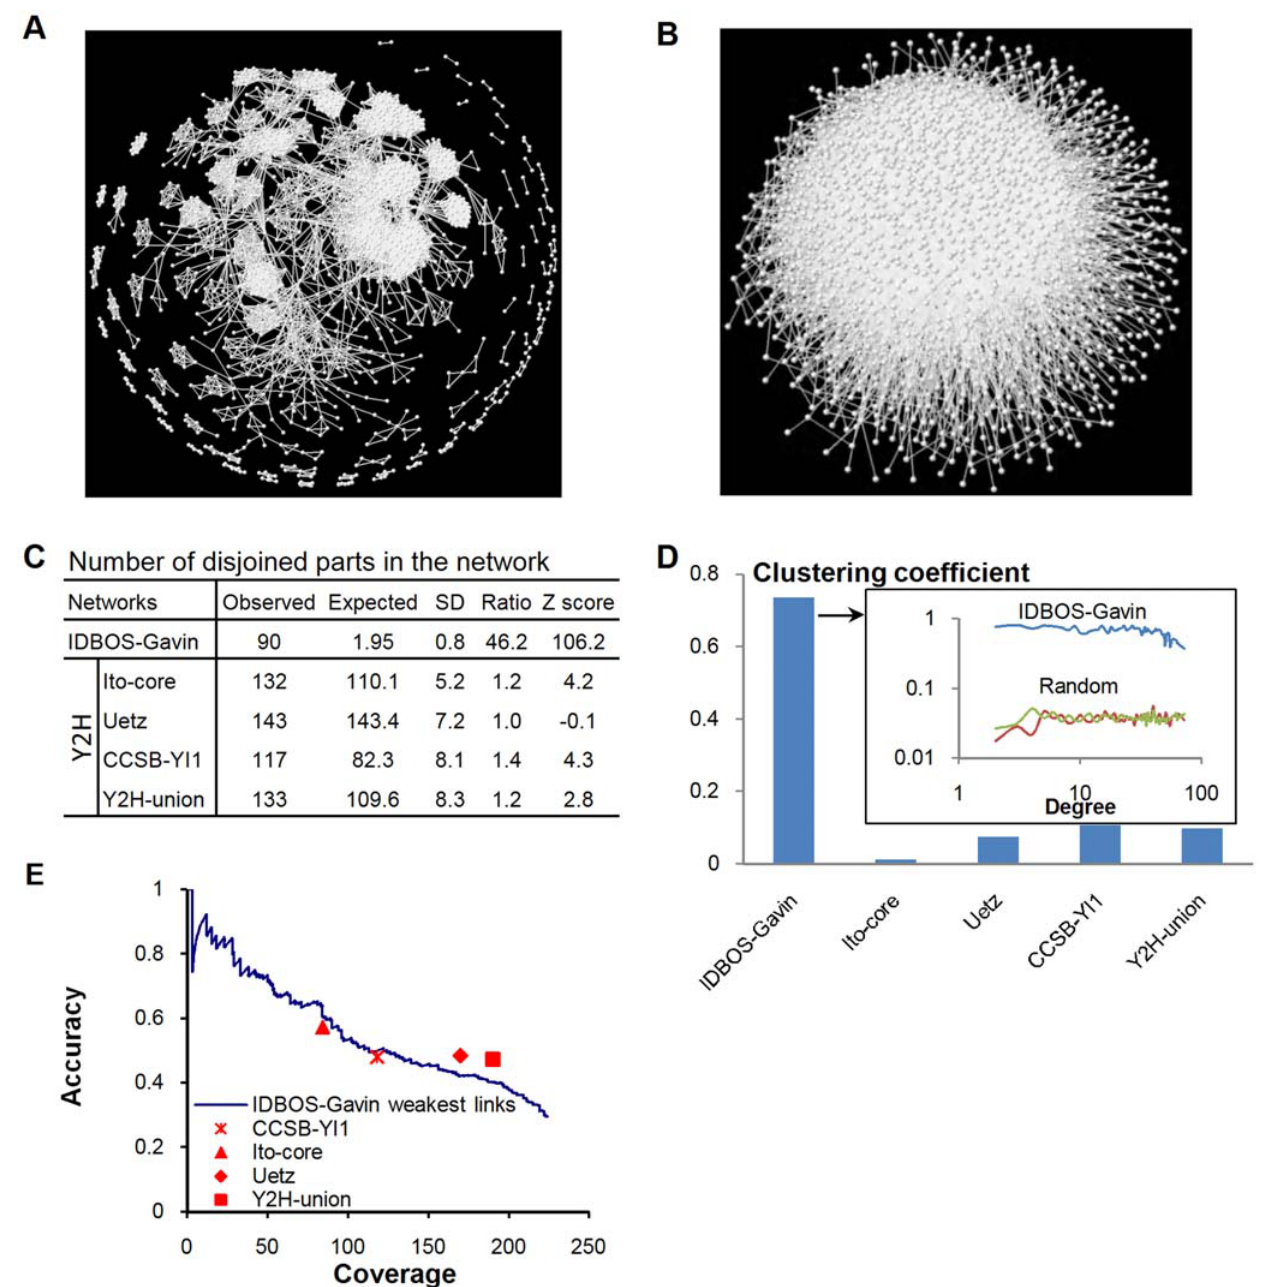
Figure 4. The high-confidence IDBOS-Gavin PIN is highly modular. Depictions of (A) the high-confidence IDBOS-Gavin PIN and (B) a commensurate, degree-preserving random network. (C) Enrichments of numbers of disjoined parts in the IDBOS-Gavin PIN and Y2H data sets of Yu et al. [6] (CCSB-YI1), Ito et al. [4] (core subset), Uetz et al. [5], and a union of these data sets [6] (Y2H-union). Expected values and standard deviations (SD) were computed from 1000 realizations of commensurate, degree-preserving random networks. (D) Clustering coefficients of the IDBOS-Gavin PIN and experimental Y2H data sets. The inset shows average clustering coefficients by degree for the IDBOS-Gavin PIN and two realizations of a commensurate, degree-preserving random network. (E) Coverage versus accuracy data for the weakest links in the IDBOS-Gavin PIN using the BGS reference set (see Materials and Methods). Also shown are coverage-accuracy values for the Y2H data sets. doi:10.1371/journal.pcbi.1000515.g004 (Figure S2). While the number of disjoined components in a network, relative to that of a commensurate random network, is not a strict measure of modularity, it does provide insight into the level of interaction localization. The IDBOS-Gavin PIN has 90 disjoined components compared to the expected 1.95 (SD =0.8) for the random equivalent based on 1000 realizations (Figure 4C).